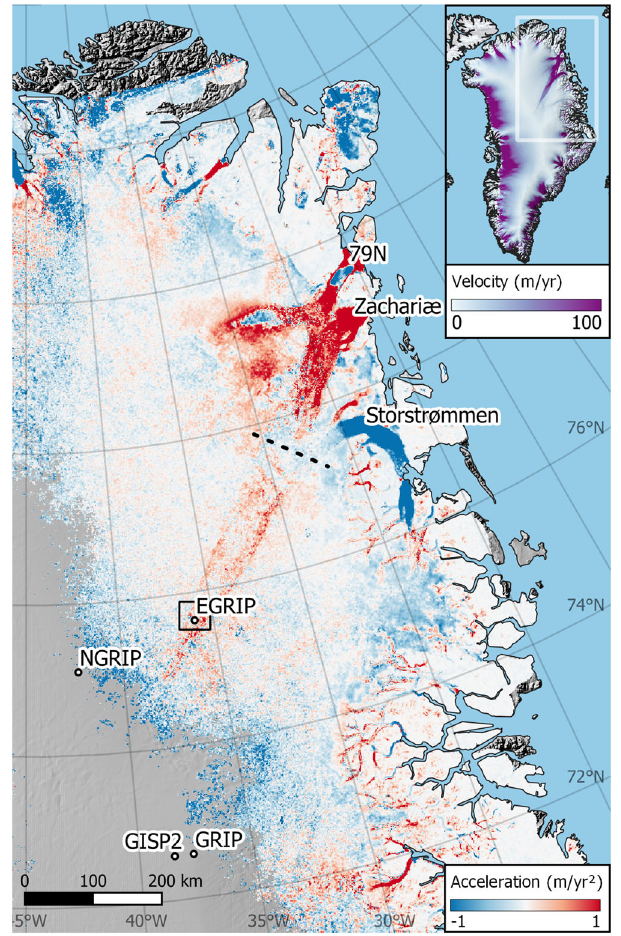
Fig.1|Along fl owiceaccelerationinNorth – EastGreenlandbasedon1985 – 2018 velocitydata. BoxnearEGRIPindicateslocationofthestakenetworkinFig.2.Grid points with less than 10years of data has been disregarded. The shear margins of theinteriorareaccelerating,indicatingthattheicestreamiswidening.Dashedline shows region of no clear pattern of acceleration separating inland change from frontal changes. Inset shows overview map colored by ice velocity 29 .